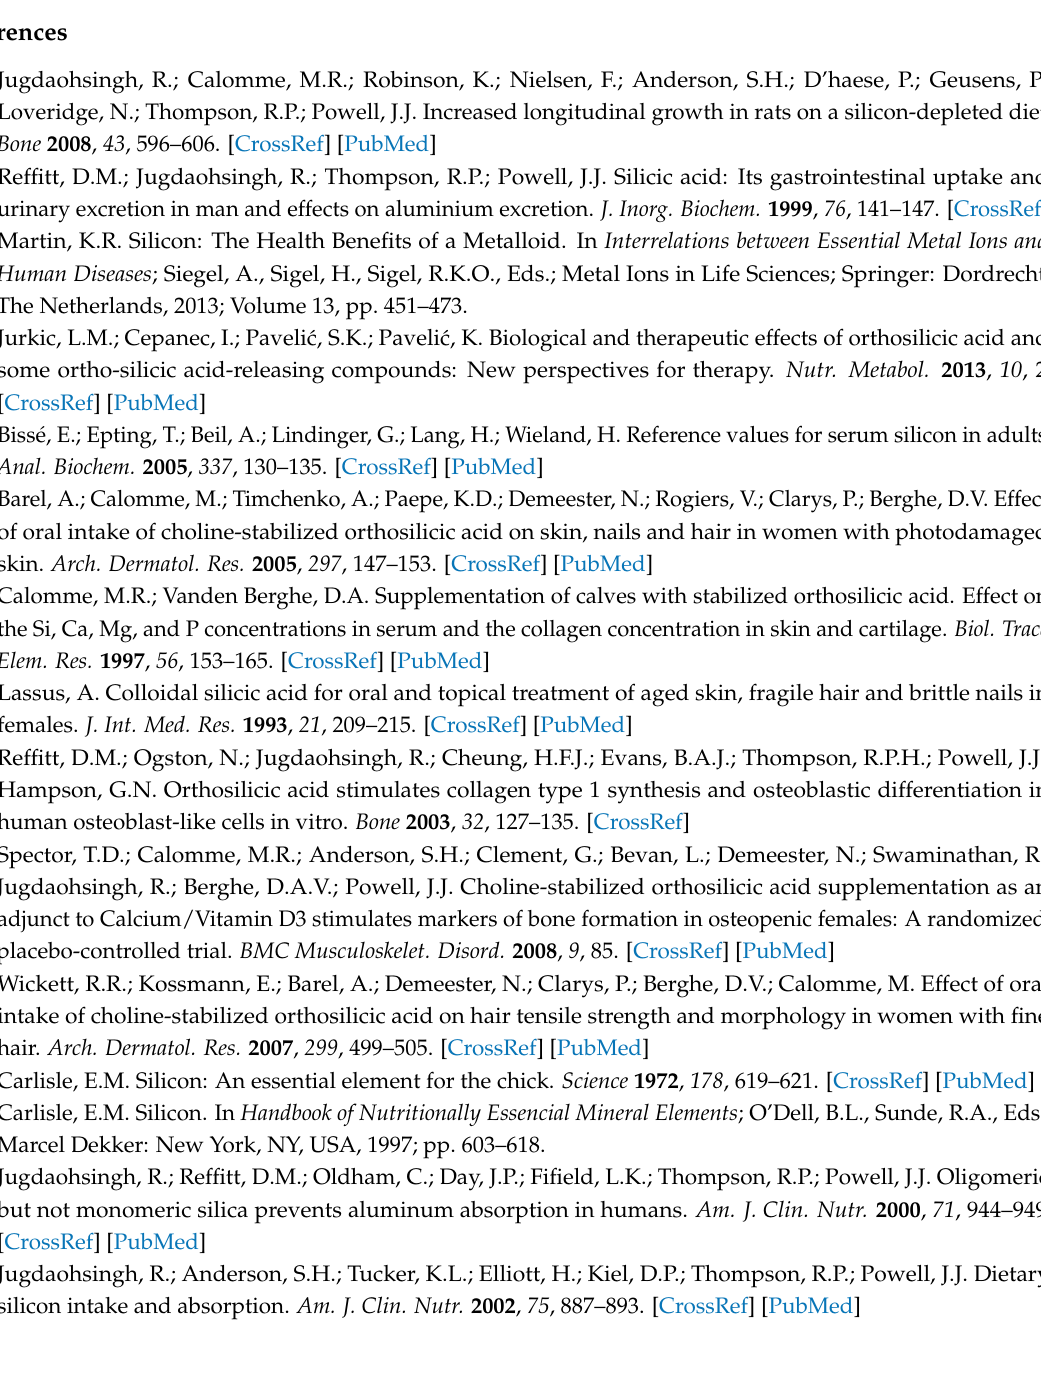
between the groups for the self-reported questionnaire. Table S10: Comparison of means for chemical variables (self-reported questionnaire), according to groups at zero and five months (T0 and T5, respectively): control group (placebo). Table S11: Comparison of means for chemical variables (self-reported questionnaire), according to groups at zero and five months (T0 and T5, respectively): group treated with maltodextrin-stabilized orthosilic acid (SiliciuMax ® capsules). Table S12: Comparison of means for chemical variables (self-reported questionnaire), according to groups at zero and five months (T0 and T5, respectively): group treated with monomethylsilanetriol (SiliciuMax ®